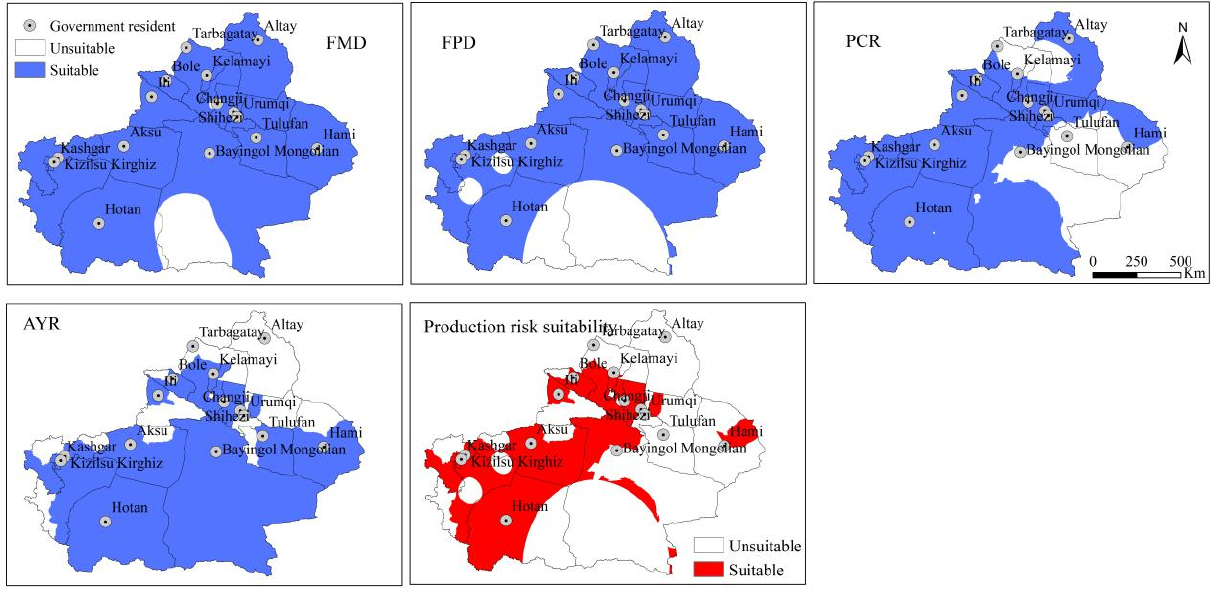
Figure 8. Suitable production risk area for cotton seed production, FMD, the frequency of meteorological disasters; FPD, the frequency of pest diseases; PCR, the precipitation change rate; AYR, the average cotton yield reduction rate over the